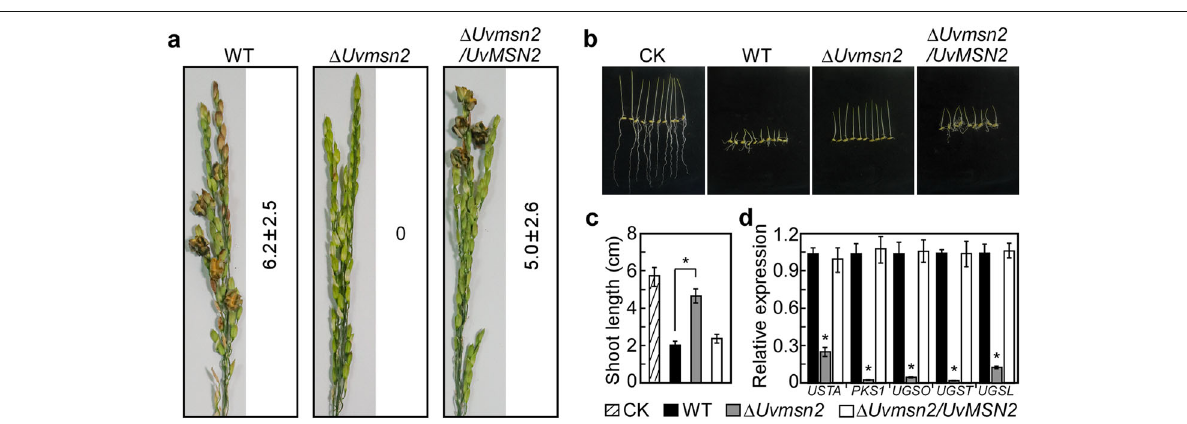
Fig. 5 UvMsn2 is essential for pathogenicity of Ustilaginoidea virens . a Conidial suspensions collected from the wild-type HWD-2, Δ Uvmsn2 and Δ Uvmsn2 / UvMSN2 strains were inoculated into rice panicles and photographed at 28 dpi. The number of false smut balls on each panicle was counted and analyzed. b Seeds of rice cultivar were incubated on filter papers soaked with blank control (liquid YT medium) or filtrates of 5-day-old YT cultures of the indicated strains. Shoot length was examined after incubation at 25°C for 5days. c Statistical analysis of the shoot length of the indicated strains. The mean values ± SD were calculated from three independent experiments, and asterisk indicates a statistically significant difference from the wild type ( P <0.01). d RT-qPCR analyses of the expression of ustilaginoidin biosynthetic genes in the indicated strains. The mean values ± SD were calculated from three independent experiments, and asterisk indicates a statistically significant difference from the wild-type strain ( P